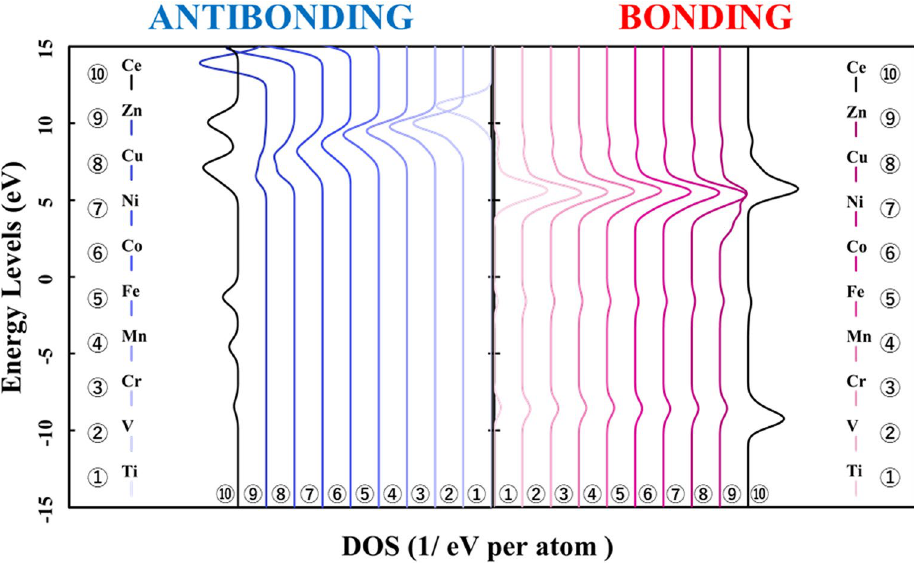
Figure 7. Energy levels of the bond composition between the doped metal and the oxygen atoms are based on the reference level as the vacuum level in the M@Ce 12 O 8 36+ cluster model (M = Ti, V, Cr, Mn, Fe, Co, Ni, Cu, Zn, Ce). The bonding and antibonding orbital components are on the right and left sides, respectively.